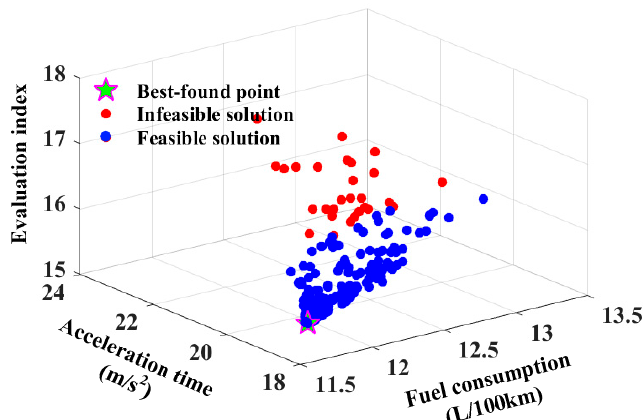
Figure 12. Pareto front of the nondominated sorting genetic algorithm-II (NSGA-II).